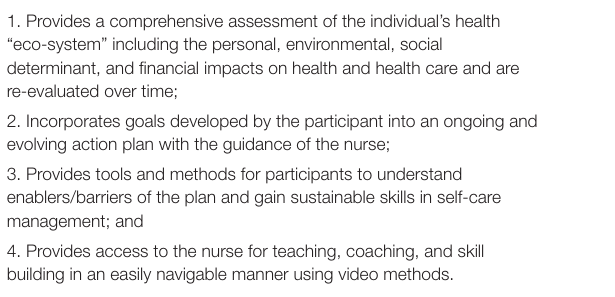
TABLE 1 | Elements of the HL